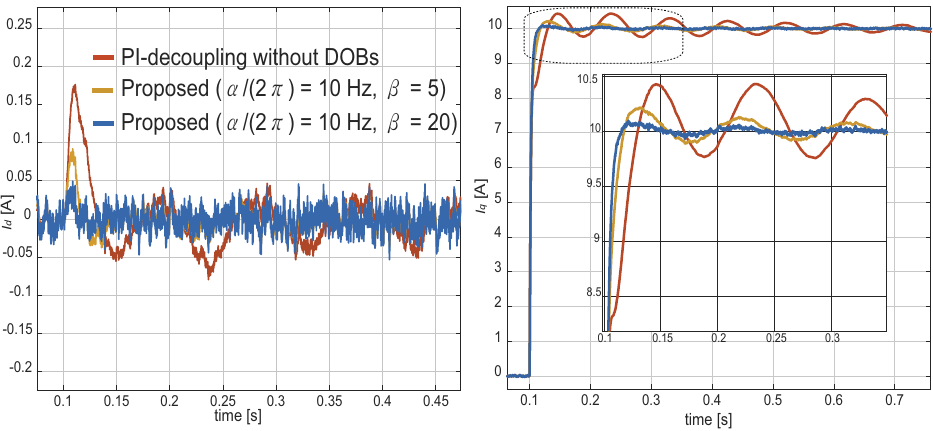
Figure 9. The d - and q -axis current step responses under speed measurement delay due to the low-pass filter.